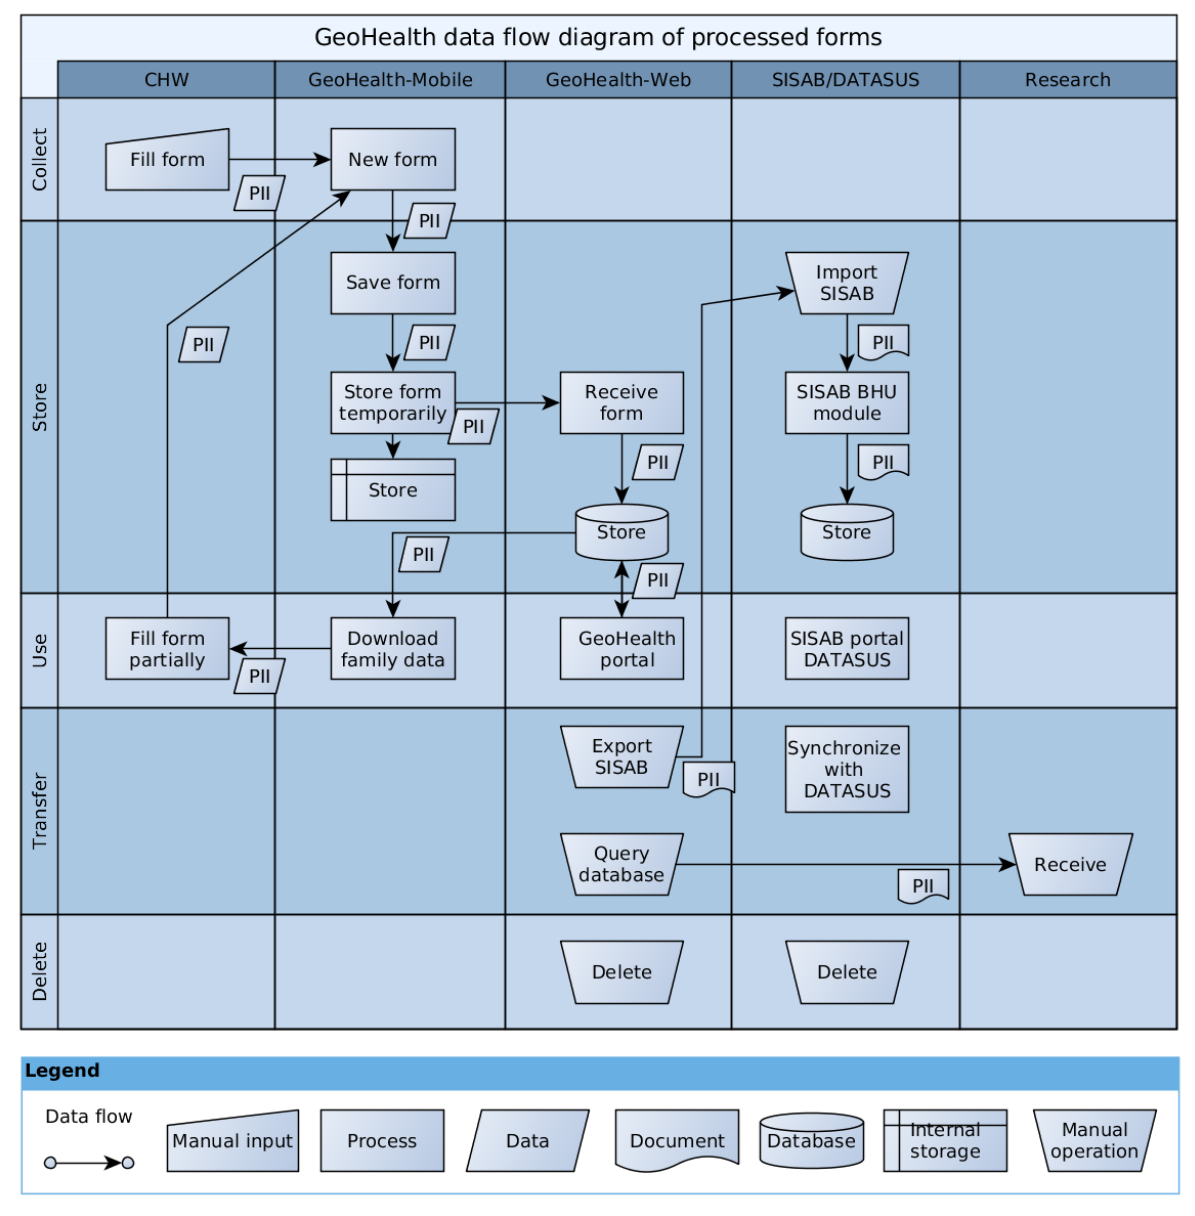
Figure 3. High-level data flow diagram of the GeoHealth environment. Acronyms: Personally Identifiable Information (PII); Basic Health